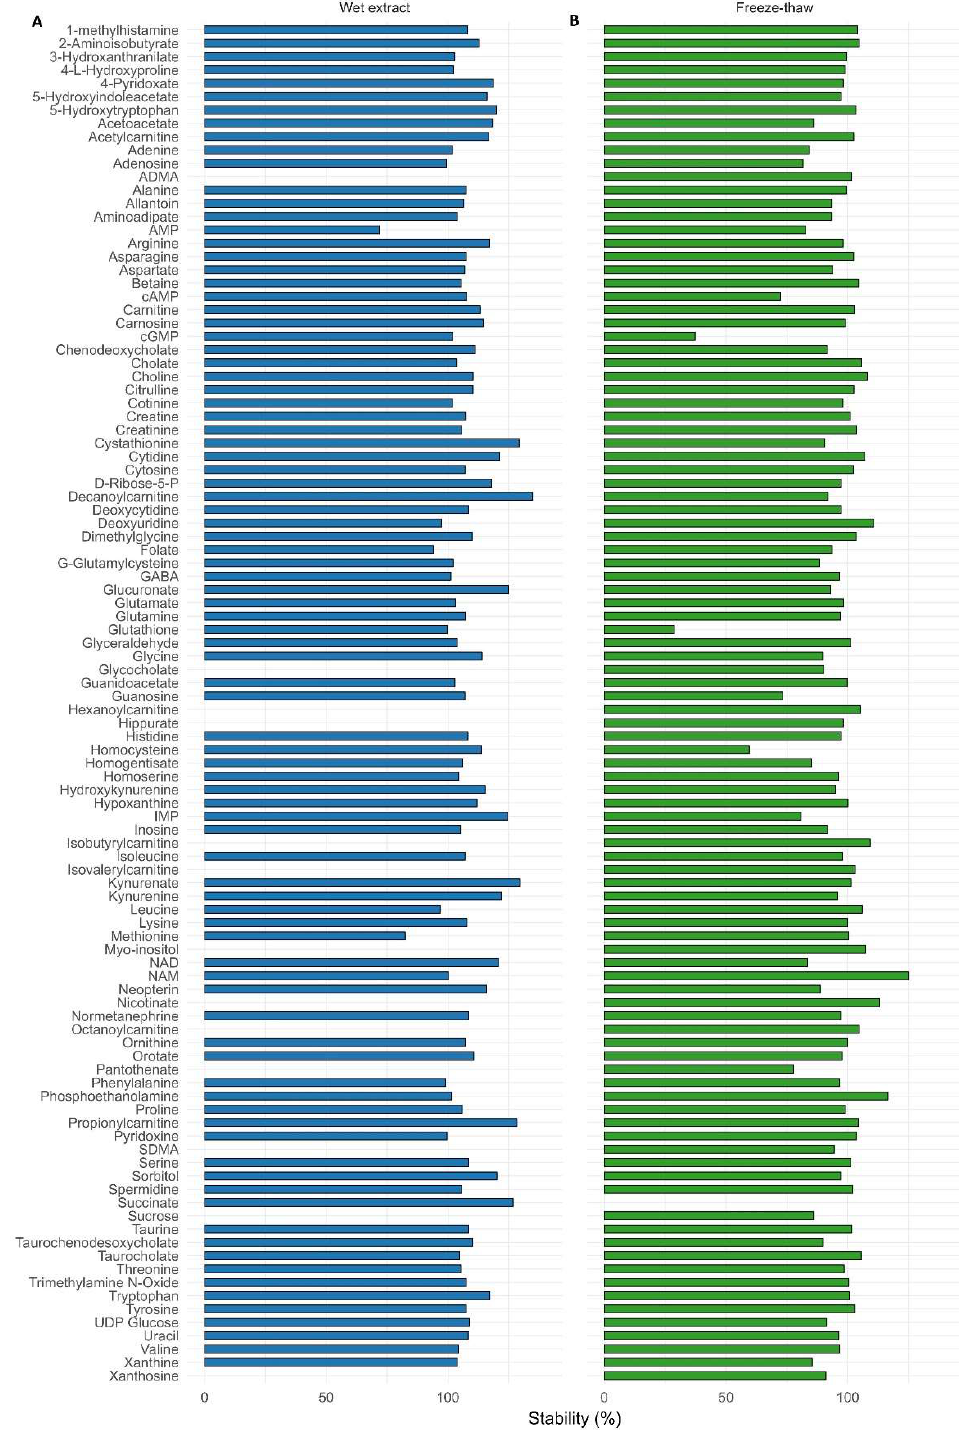
Figure 4. Percentage mean stability was calculated for three different concentrations (low, medium, and high) spiked in QC serum (N = 6 at each level) during ( A ) wet extract and ( B ) freeze-thaw stability for all the metabolites.